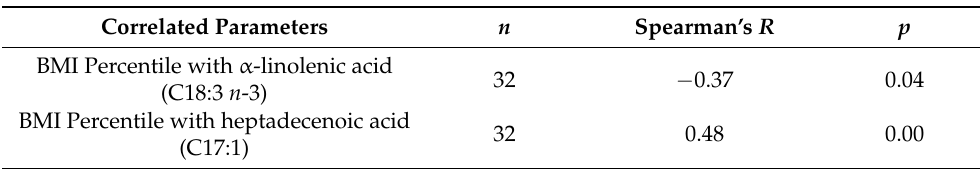
Table 7. Select data on the correlations of BMI with fatty acids in the erythrocyte membrane that had statistically significant